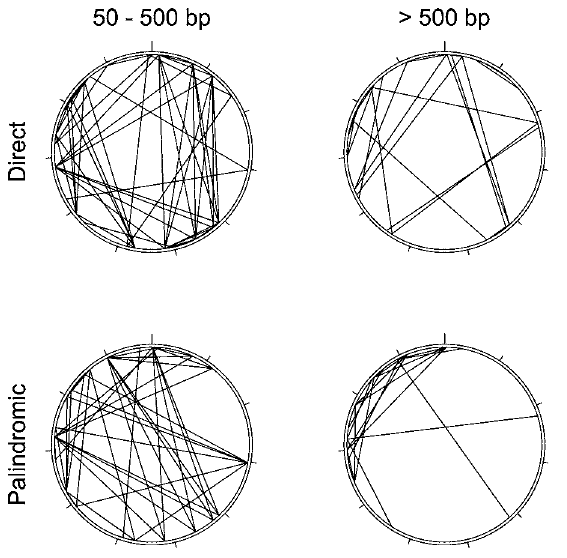
Figure 4. Organization of Direct and Palindromic Repeats in w Bm Circles represent the complete genomic sequence of w Bm. Repeats were identified using the REPuter program [182] and are connected by line segments. Direct repeats are shown in the graphs in the top row, while palindromic repeats are shown in the lower row of graphs. The left column graphs display repeats of 50 to 500 bp in length. The rightmost graphs display repeats of greater than 500 bp in length. DOI: